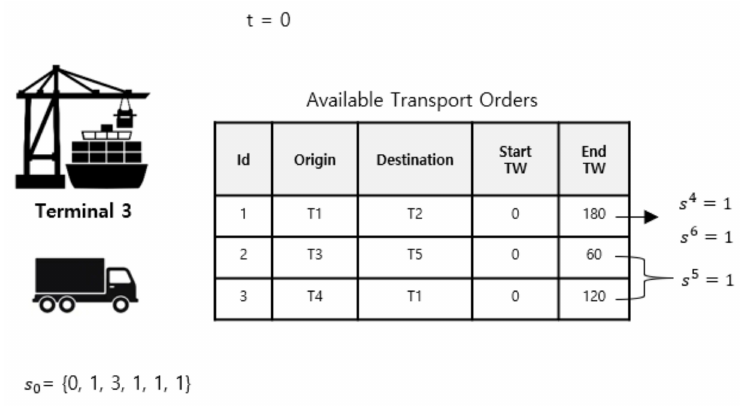
Figure 3. Example of state at time step t =